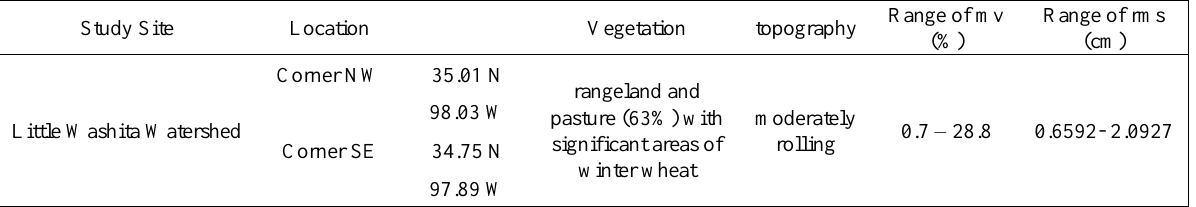
Table 1. Study area